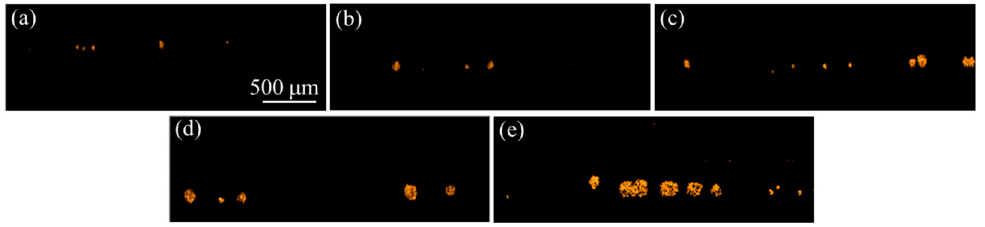
Figure 5. 2D OCT cross-sectional OCT images of cell colonies obtained at the time points of ( a ) Day 1, ( b ) Day 2, ( c ) Day 3, ( d ) Day 4, and ( e ) Day 5, respectively.